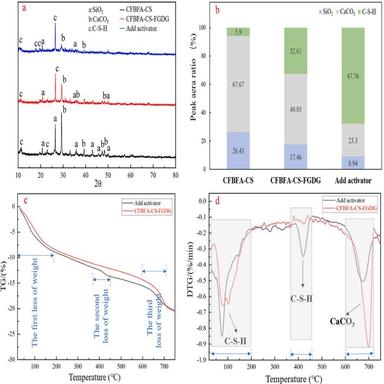
Characterization analysis of materials by activator (a: XRD analysis, b: XRD mineral composition area analysis, c: TG analysis, d: DTG analysis).